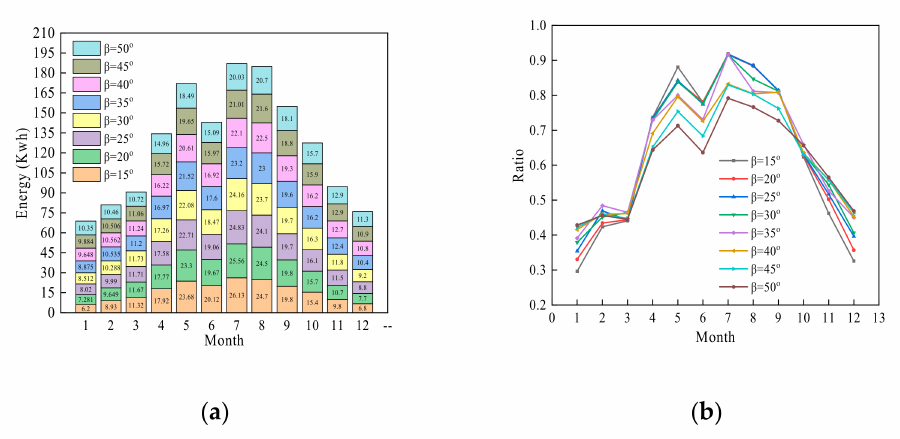
Figure 15. ( a ) Schematic diagram of the energy that can be provided by the SC throughout the year under different I SC . ( b ) Schematic diagram of the ratio of heat provided by the SC in the total heat supply of the system under different I SC